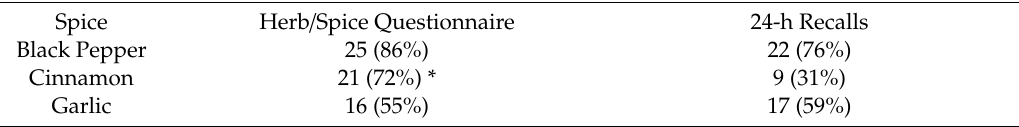
Table 2. Comparison between the herb / spice questionnaire and the 24-h recalls of reported use of the most commonly consumed herbs and